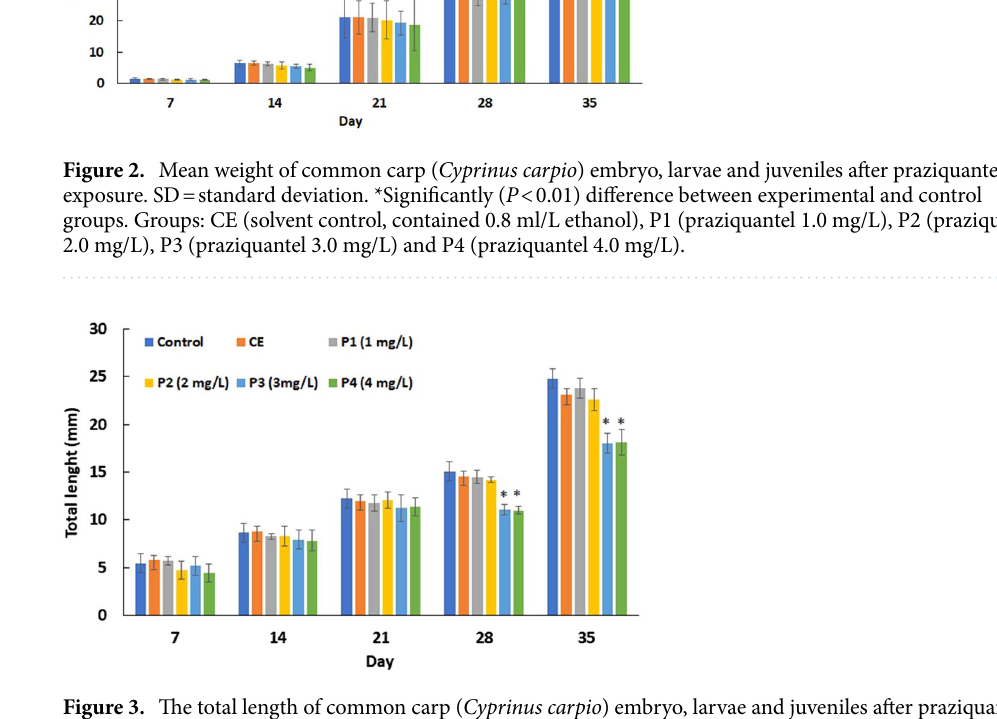
Figure 3. The total length of common carp ( Cyprinus carpio ) embryo, larvae and juveniles after praziquantel exposure. SD = standard deviation. *Significantly ( P < 0.01) difference between experimental and control groups. Groups: CE (solvent control, contained 0.8 ml/L ethanol), P1 (praziquantel 1.0 mg/L), P2 (praziquantel 2.0 mg/L), P3 (praziquantel 3.0 mg/L) and P4 (praziquantel 4.0